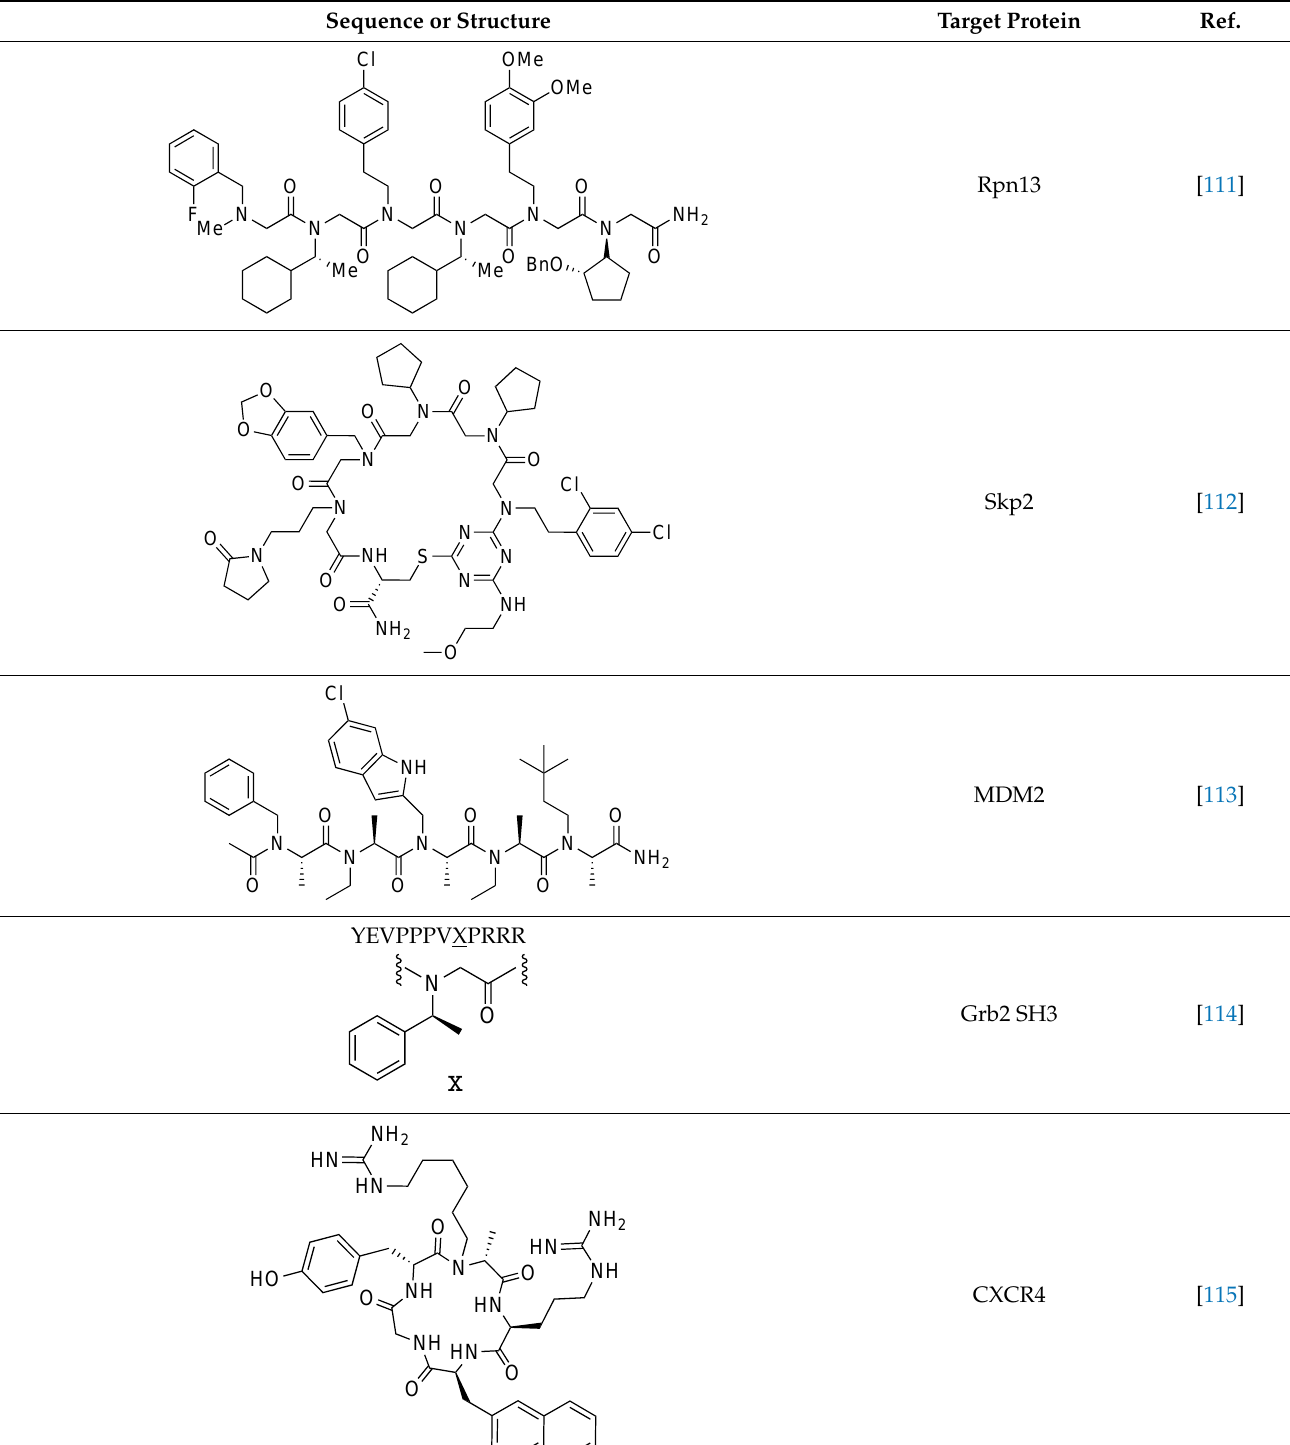
Sequence or Structure Target Protein Ref.